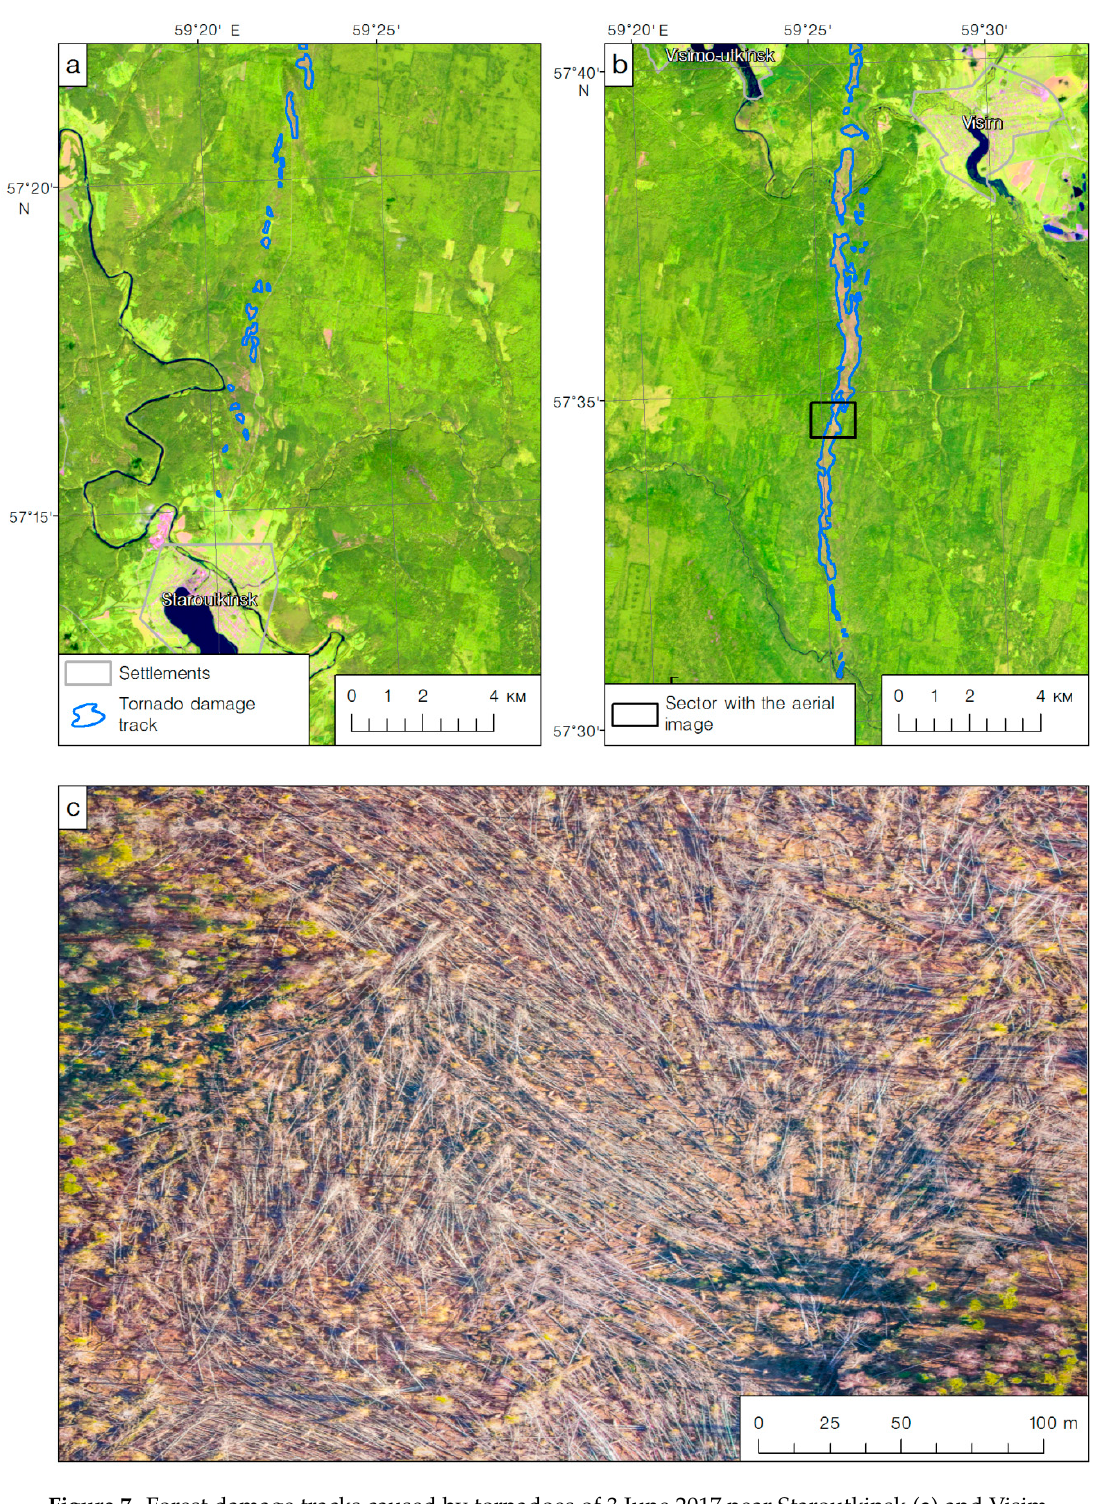
Figure 7. Forest damage tracks caused by tornadoes of 3 June 2017 near Staroutkinsk ( a ) and Visim ( b ) settlements, and the high-resolution aerial image of wind-damaged forest ( c ) of the tornado track near Visim.